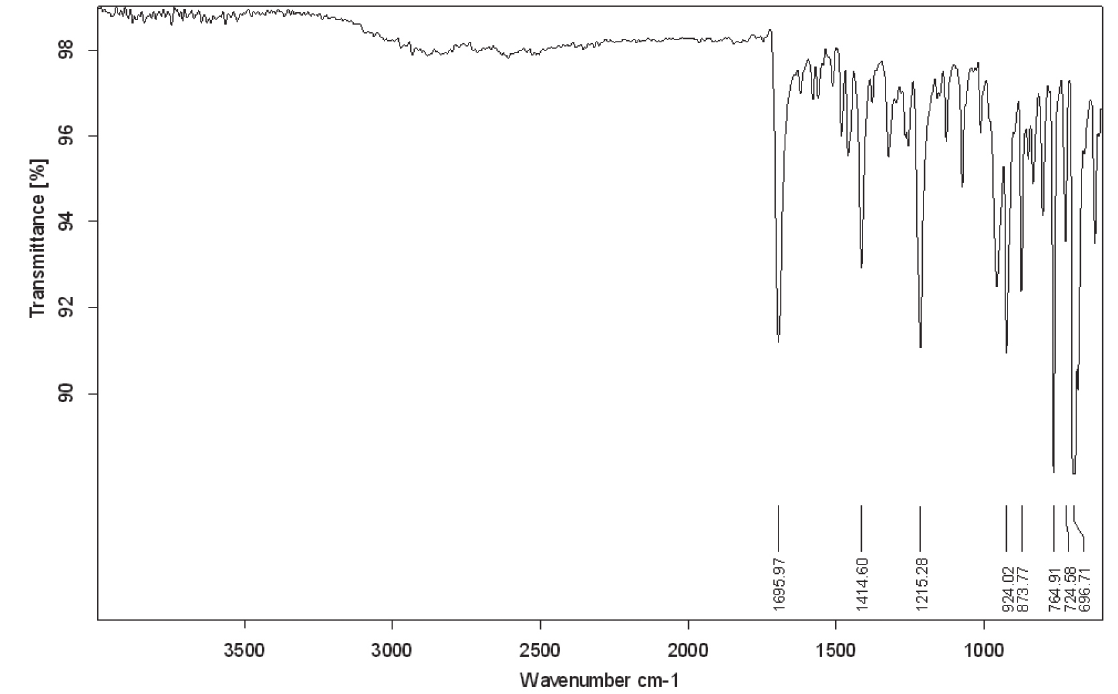
FIGURE 7 - FTIR spectra of